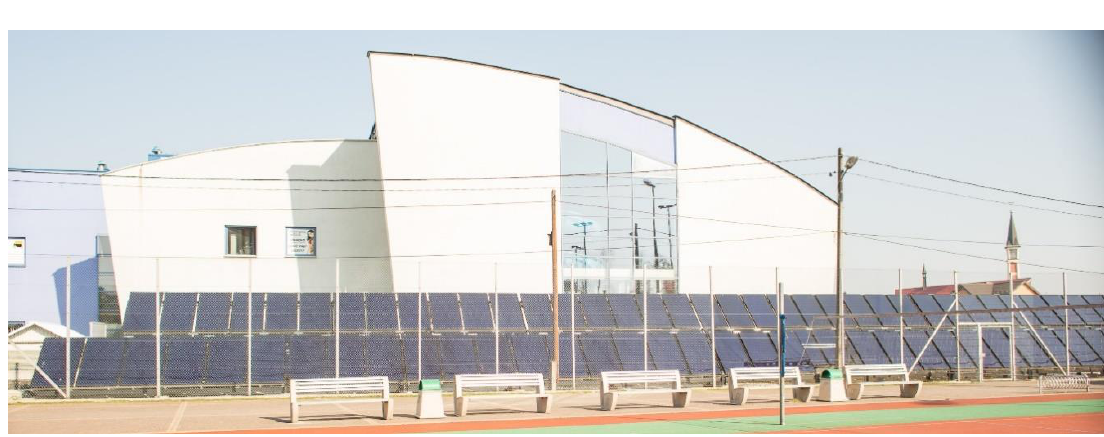
Figure 1. The flat plate collector (FPC) installation in Brzesko.